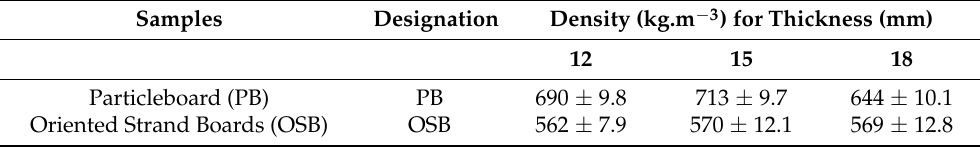
Table 1. The density of PB and OSB samples according to EN 323: 1996 [67].